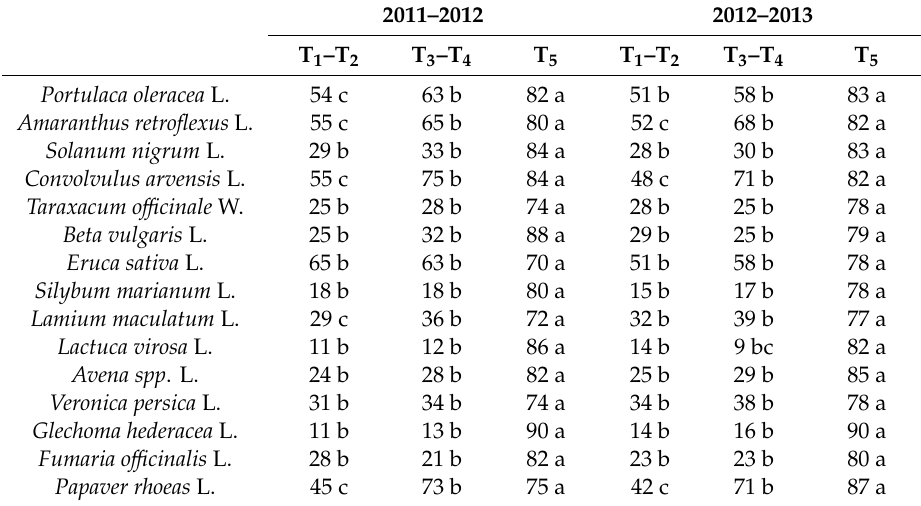
Table 4. Mean Weed Control E ffi ciency (WCE) percentage of the 50 diluted oils (T 1 –T 2 ),